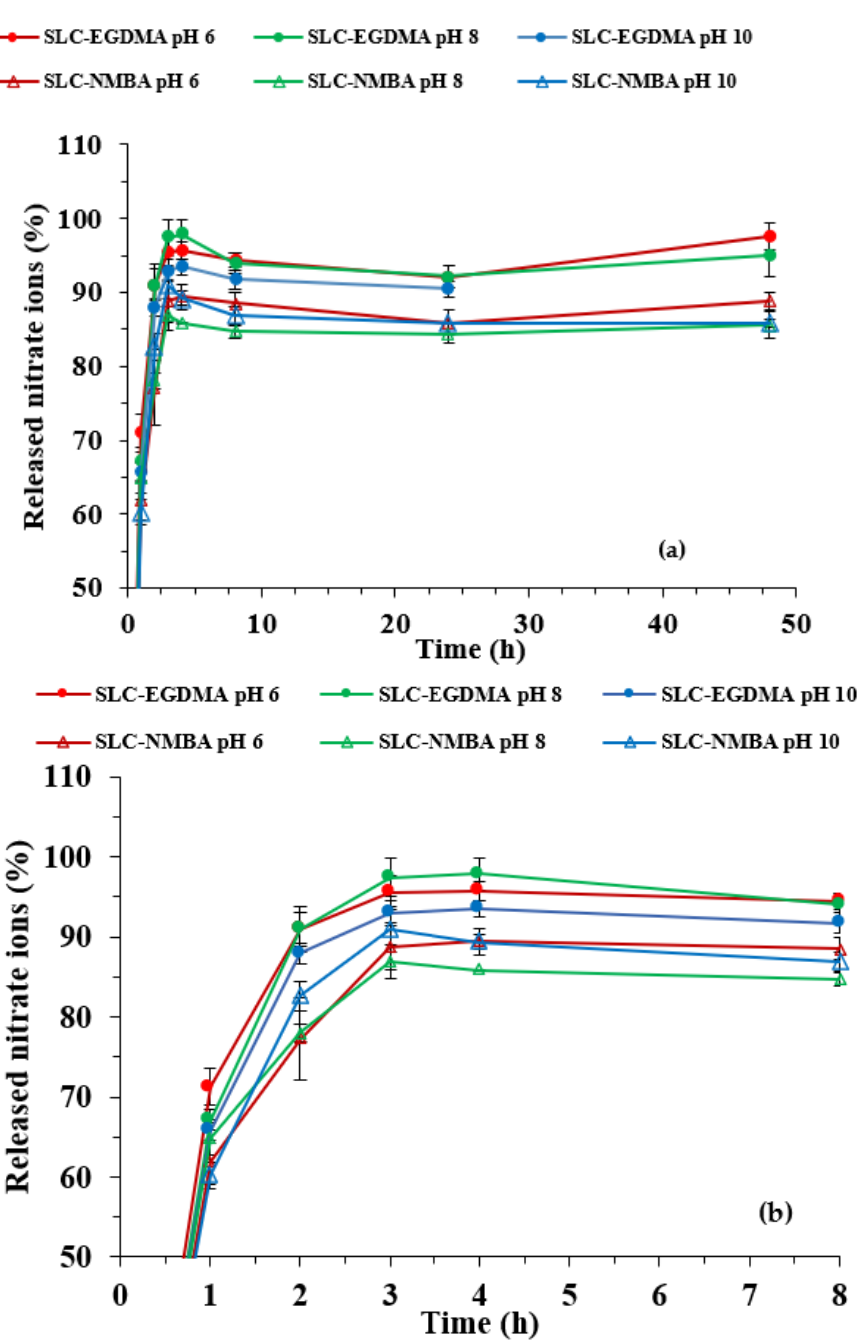
Figure 6. Release kinetic curves for SLC systems at pH 6, 8, and 10 ( a ) up to 48 h and ( b ) first hours.